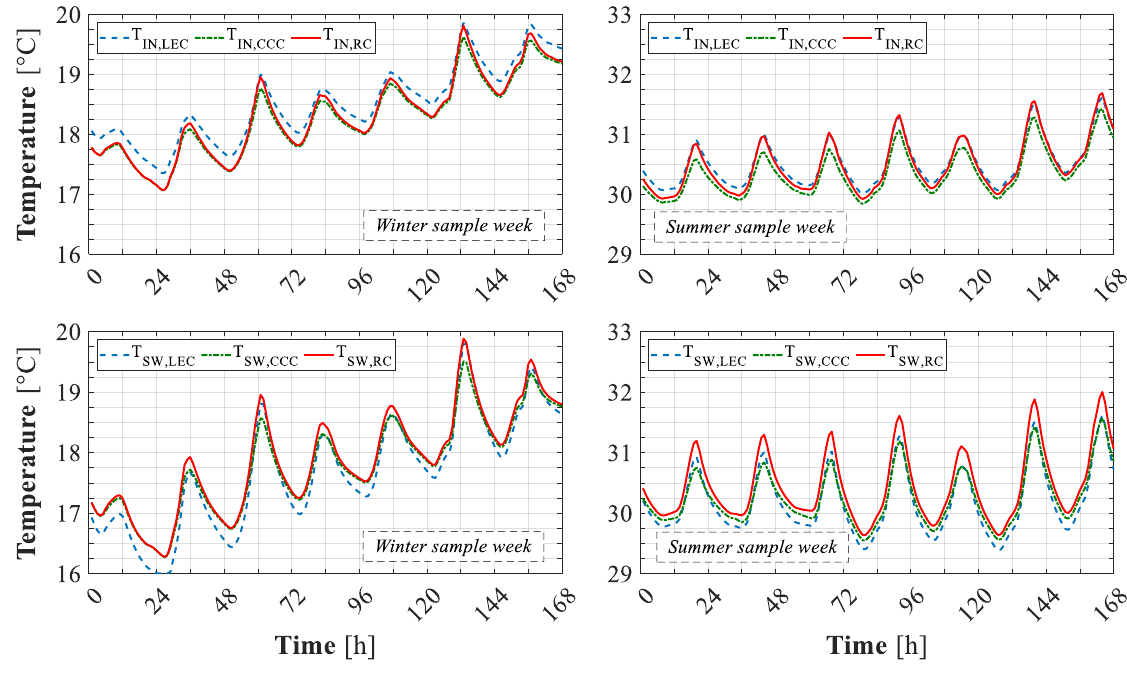
Figure 28. Indoor air and SW wall internal surface temperature (T IN and T SW , respectively) achieved with low-e plaster (LEC), cool coating (CCC) vs. the reference case (RC)—Winter ( left ) and summer ( right ) sample week.